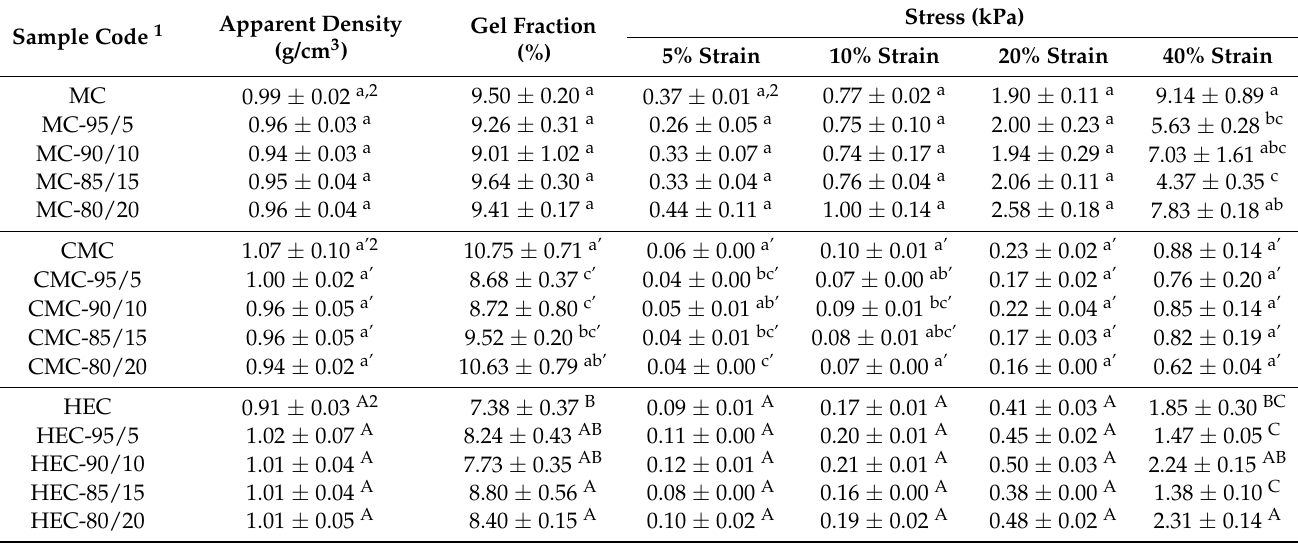
Table 3. Apparent density, gel fraction, and compressive properties of cellulose/WPU composite